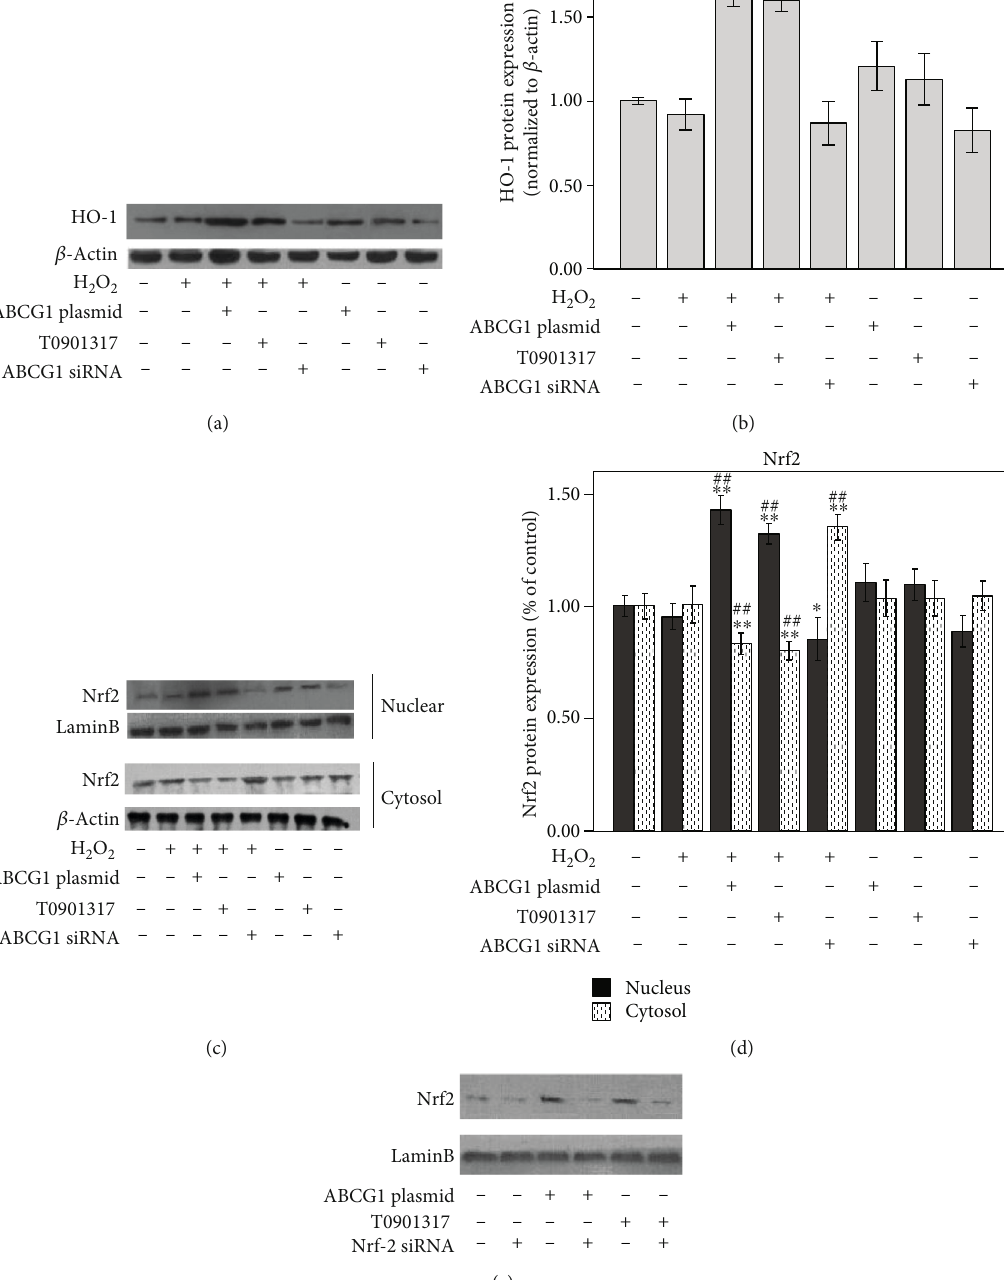
O . HUAECs were transfected with the speci fi c 2 2 O or not. (a, b) Antioxidant HO- 2 2 O 2 2